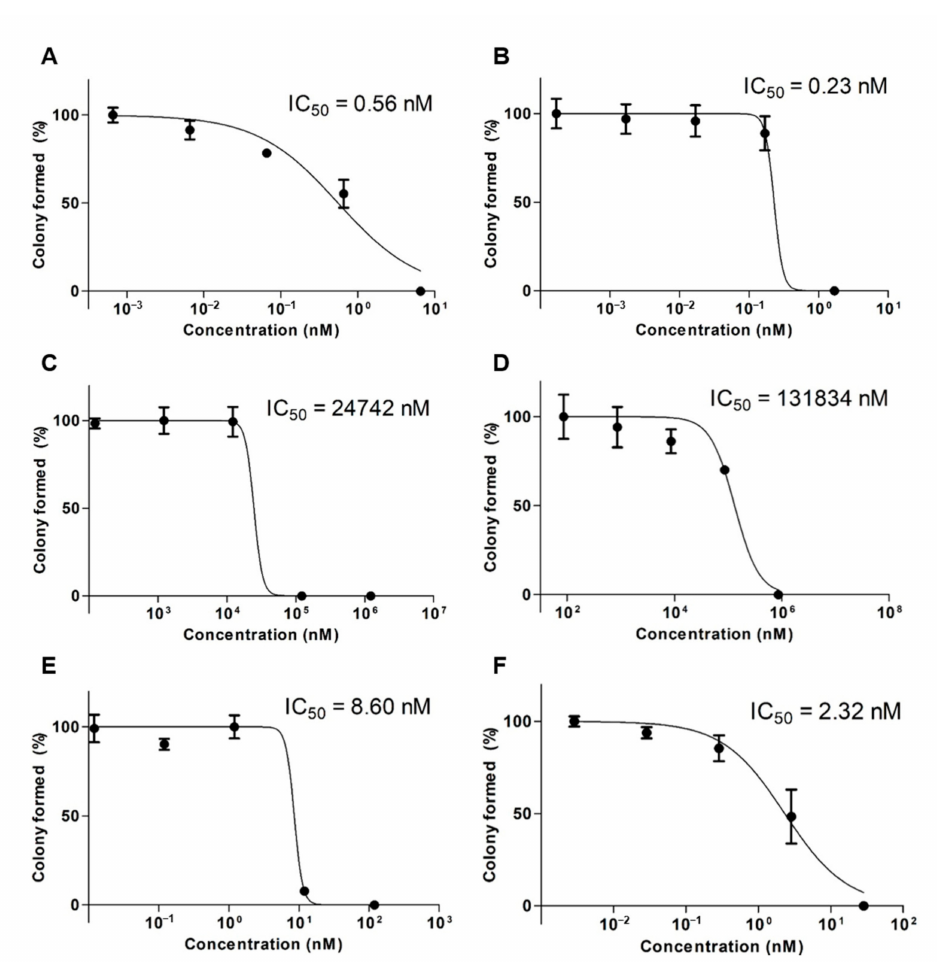
Figure 4. In vitro clonogenic assay results after the treatment of A549 cells with ( A ) docetaxel (DTX) free drug, ( B ) DTX- loaded mPEG- b -PCL micelles, ( C ) osthol (OTH) free drug, ( D ) OTH-loaded mPEG- b -PCL micelles, ( E ) DTX/OTH free drug, and ( F ) DTX/OTH-loaded mPEG- b -PCL